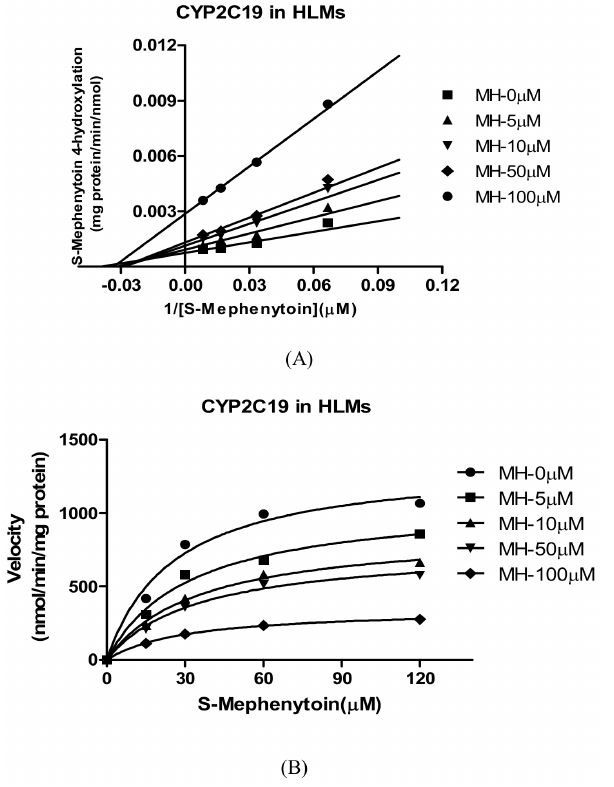
Figure 7. Double reciprocal (Lineweaver-Burk) plots for direct inhibition of S-Mephenytoin 4- hydroxylation (A) and K i values (B). Note: The inhibition of CYP1A2 activity by MH can be best described as a full competitive inhibition by different concentrations of MH (0–100 m M) in HLM incubations (0.5 mg ? mL -1 protein). The data points are mean values of triplicate incubations. Non-linear regression analysis of the S- Mephenytoin 4-hydroxylation versus substrate concentration was performed to obtain K i